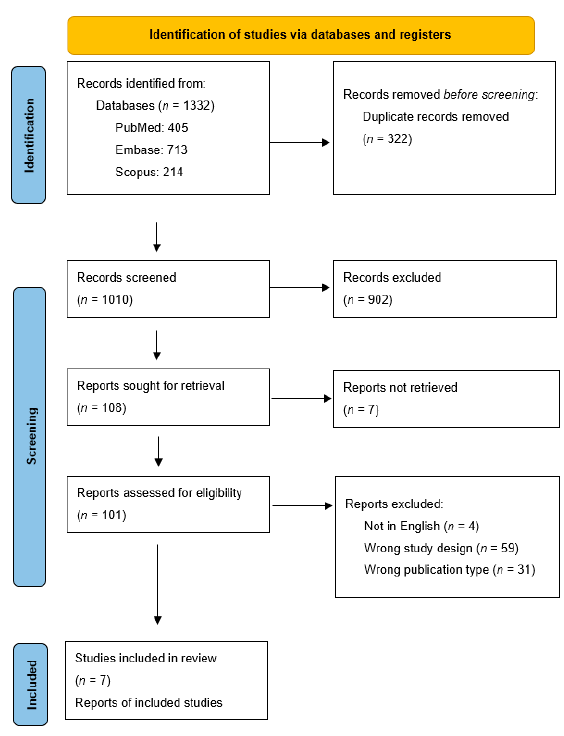
Figure A1. PRISMA 2020 Flow Diagram.